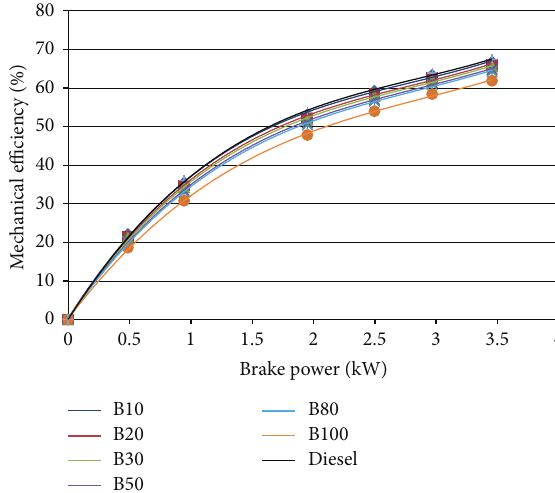
Figure 7: Mechanical efficiency versus brake power.